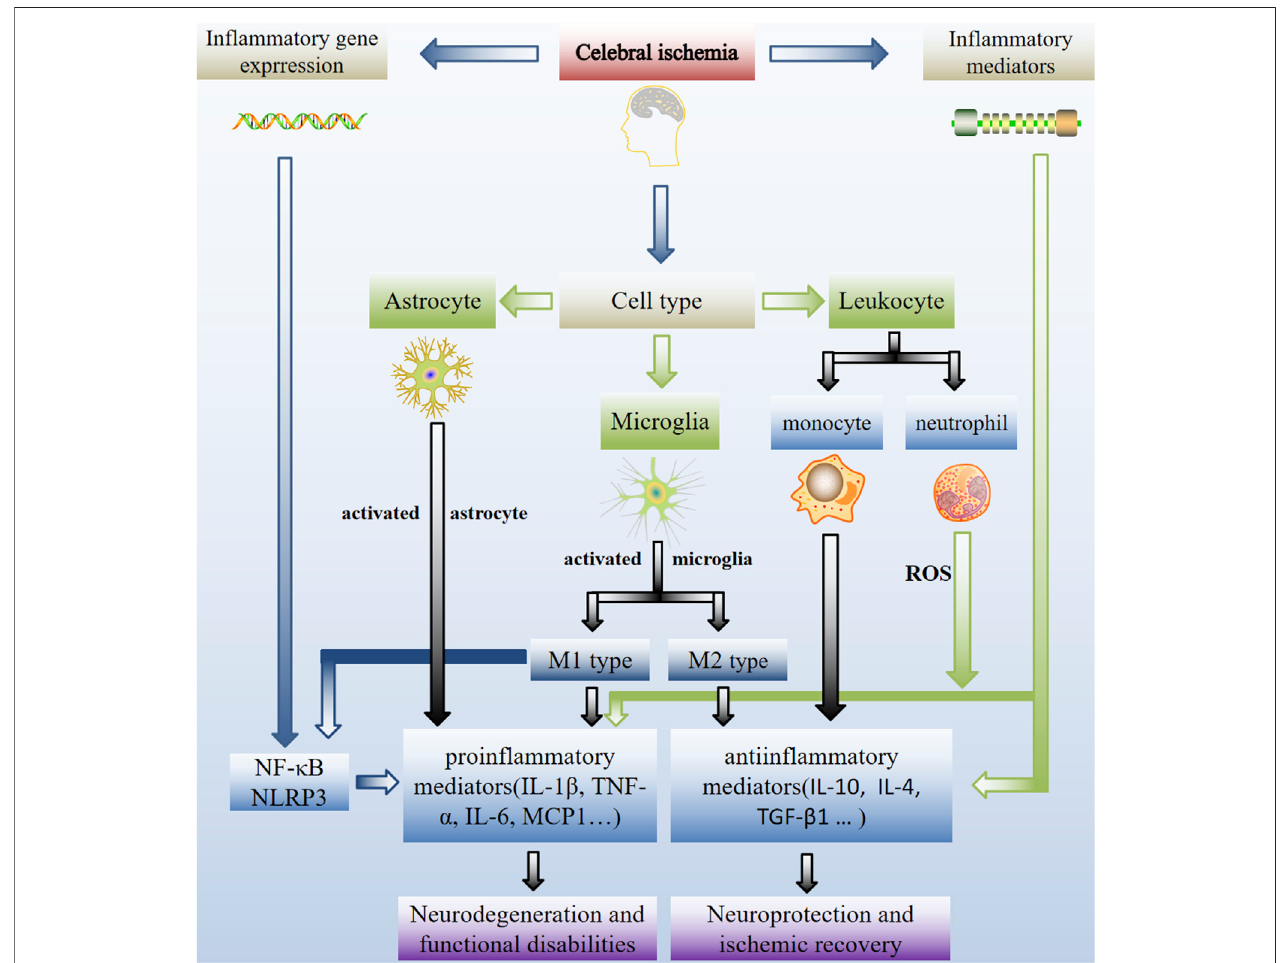
FIGURE 1 | Schematic representation of in fl ammatory mechanisms in cerebral ischemia. In fl ammation is crucial to the pathogenesis of ischemic stroke. Critical in fl ammatory and anti-in fl ammatory events involved in in fl ammatory gene expression, different cell types and in fl ammatory mediators contribute to ischemic injury. In fl ammation inhibition is a possible treatment option for ischemic stroke-related neuro-in fl ammatory damage. Activation of local microglia and in fi ltrating macrophages from the compromised BBB occurs during cerebral ischemia. Microglia activation has two-way role (a double-edged sword). Stimulation the activity of microglia migratetoinjuredneuronsandthenswitchetotheM1orM2phenotype,whichisimplicatedinnerveinjuryandrepair.Asaresult,afteranischemicstroke,controllingthe M1/m2 phenotype of microglia is critical for brain healing.